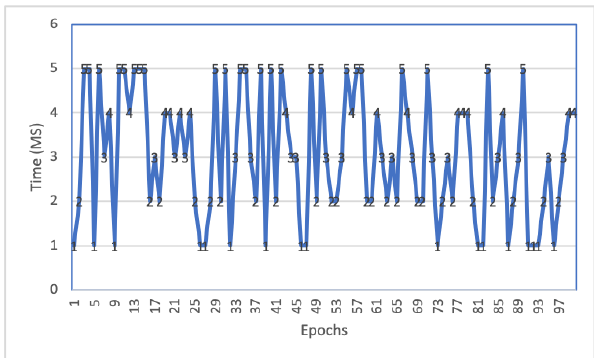
Figure 7. Block Creation